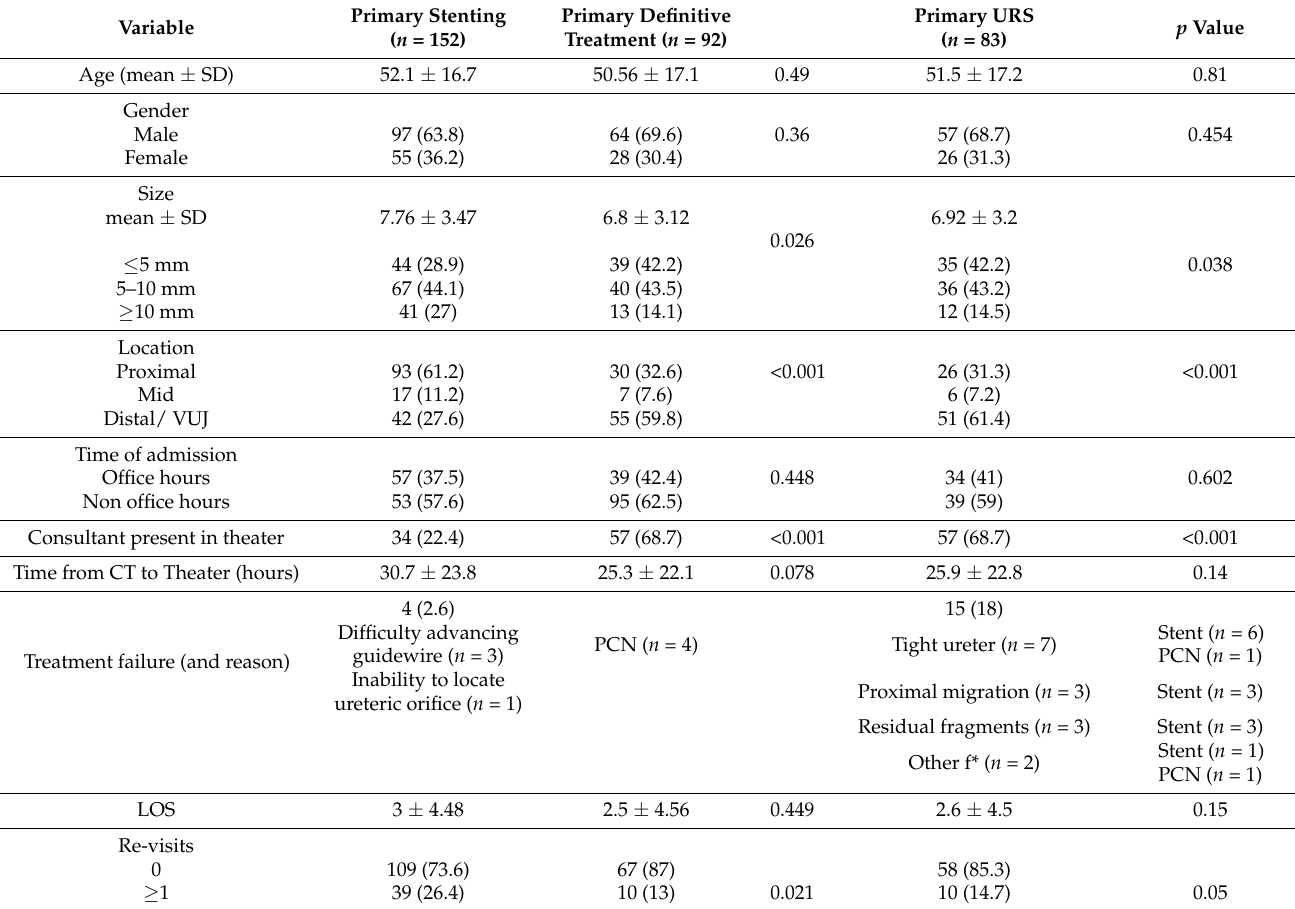
Table 1. Univariate analysis of predictive factors for the different primary treatments types.